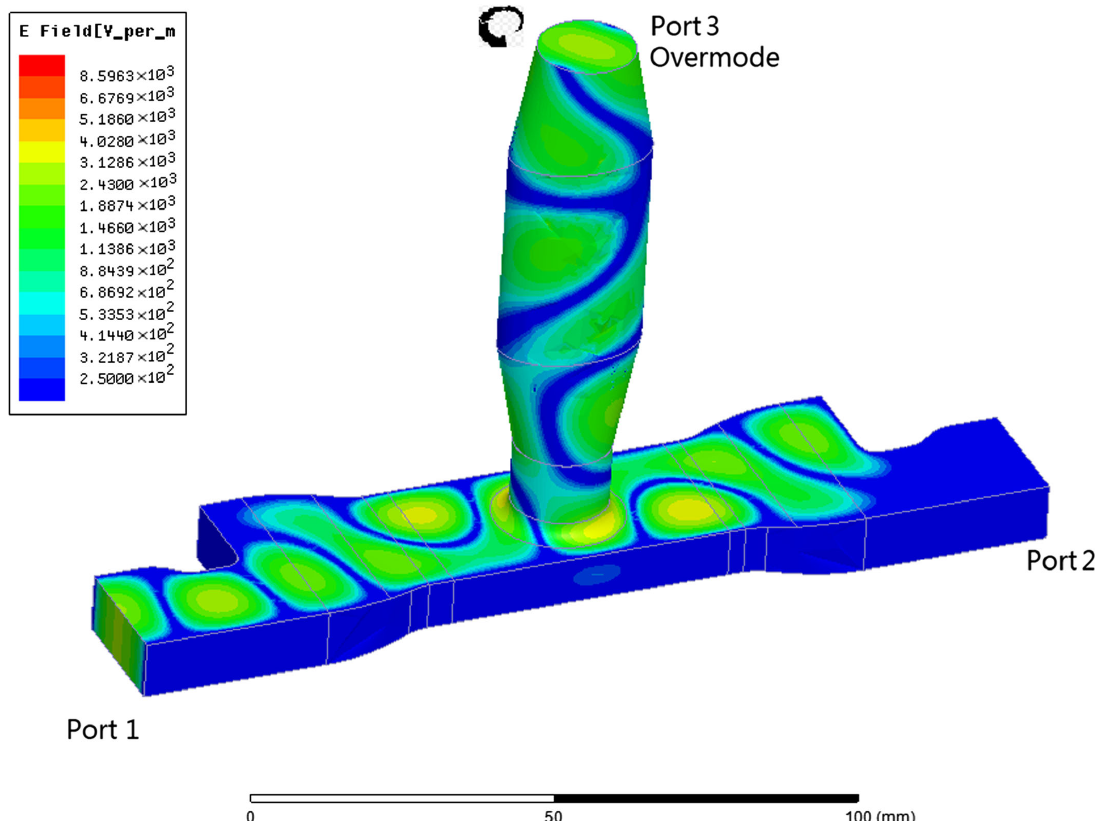
FIG. 9. Final assembly of ellipse corrector and OMT converter. Port 1 and 2 are standard WR 90 rectangular waveguides and port 3 is the circular waveguide which supports two TE11 polarizations. The input power on port 1 is